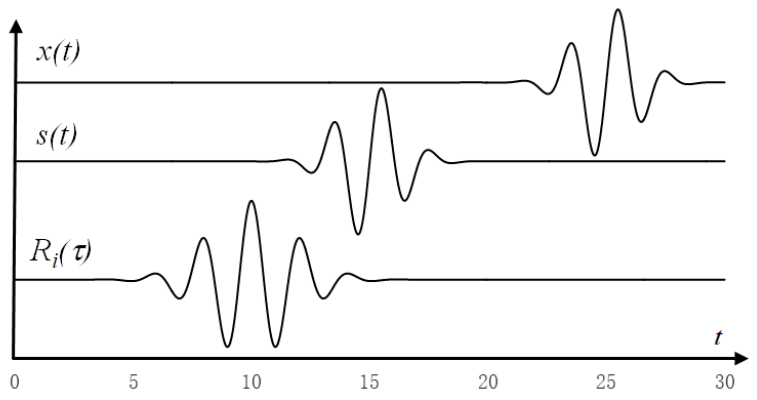
Figure 2. Two time series and their cross-correlation functions.